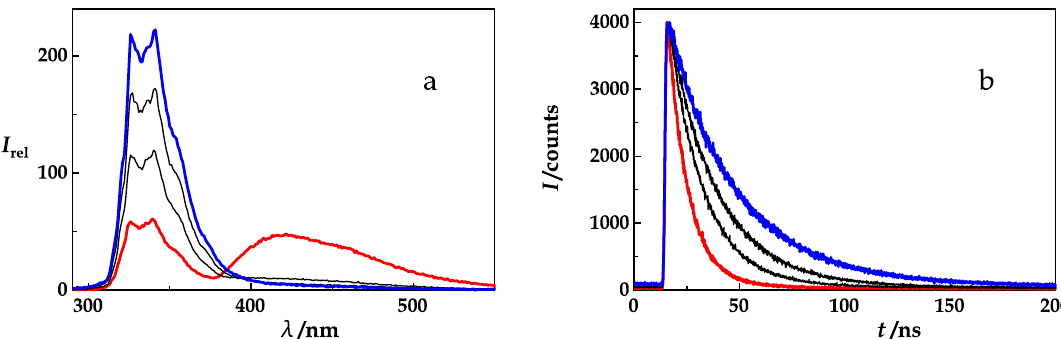
Figure 2. ( a ) Steady-state fluorescence emission spectra and ( b ) time-resolved fluorescence decays ( λ obs = 350 nm) of NAla-(GS) 6 -Dbo-NH 2 upon excitation at 280 nm at ethylene glycol concentrations (vol/vol) ranging from 0% (red) to ca. 92% (blue). The donor lifetime increases from 10.3 ns (red curve) to 34.3 ns (blue curve).